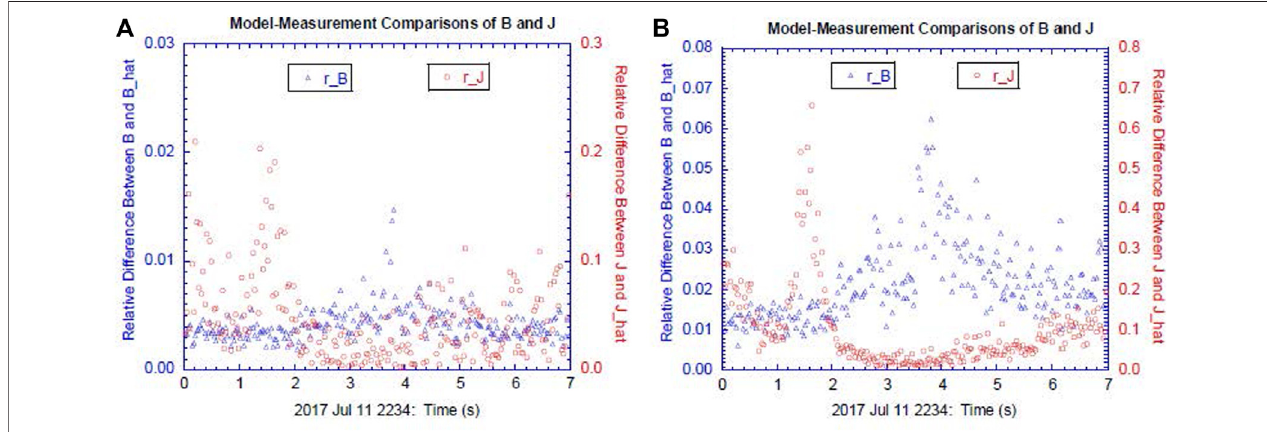
FIGURE 3 | Relative differences ( γ B , γ J ) of the reconstructed (B , J) fi elds based on MMS measurements shown in Figure 1 . Panels (A) and (B) correspond to two cases of a standard setting of σ in Eq. 8 with σ (cid:1) 0 . 1 (cid:2) σ B and an alternative setting of σ (cid:1) (cid:2) σ B ,